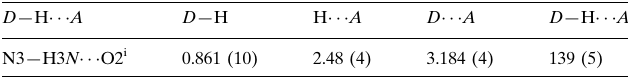
Hydrogen-bond geometry (A˚ , (cid:1)